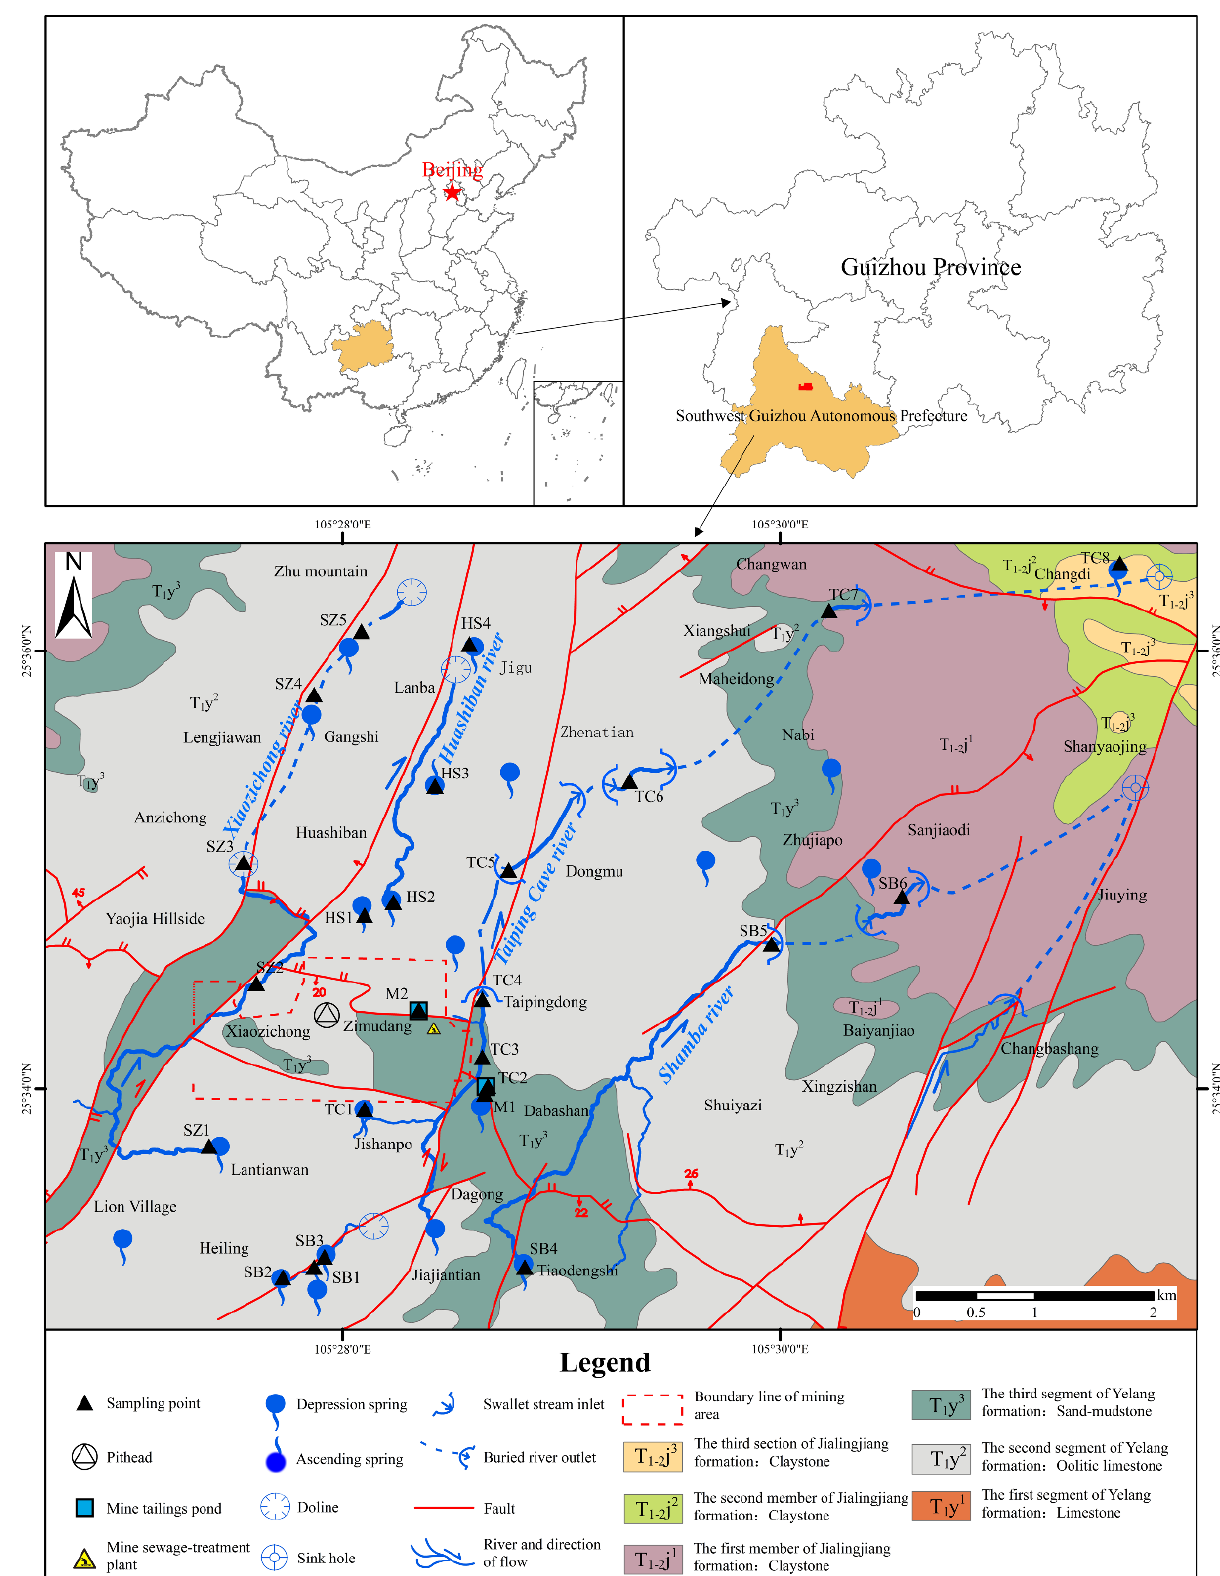
Figure 1. Location, lithology and sampling points of the study area. Except for “Zimudang, Beijing, Guizhou Province, Southwest Guizhou Autonomous Prefecture”, the other place names in the figure represent villages.